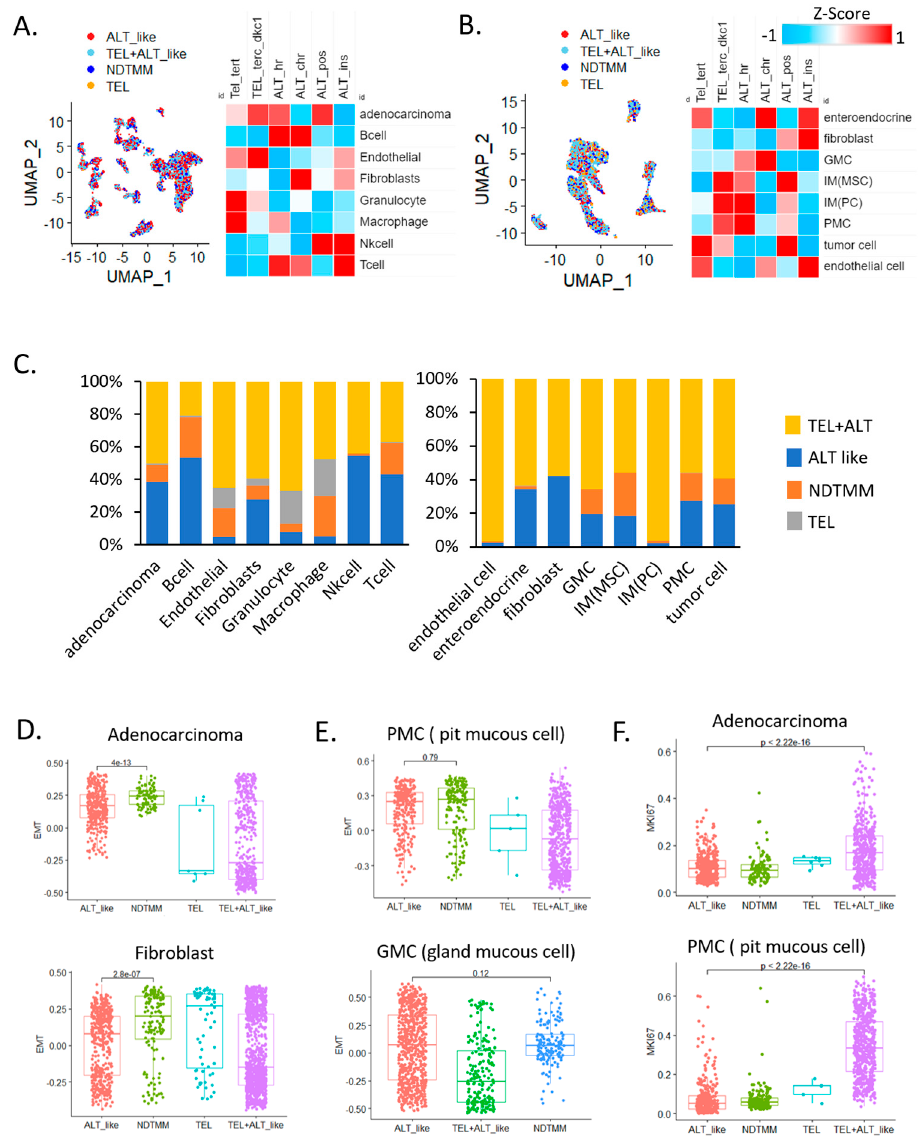
Figure 1. Single − cell analysis revealed telomere maintenance mechanisms (TMMs) in gastric cancer (GC). Uniform manifold approximation and projection (UMAP) and heat map of TMM activity of eight single − cell types in ( A ) adenocarcinoma, B cells, endothelial cells, fibroblasts, granulocytes, macrophages, natural killer (NK) cells, and T cells (12,422 cells, cohort 1) and ( B ) enteroendocrine cells, fibroblasts, gland mucous cells (GMC), mesenchymal stem cells, pit mucous cell (PMC), tumor cells, and endothelial cells (5927 cells, cohort 2). ( C ) Bar graph showing frequency of TMM types in eight single − cell types (12,422 cells, left); different cohort eight single − cell types (5927 cells, right). Boxplot of epithelial–mesenchymal transition (EMT) signature of ( D ) adenocarcinoma cells, fibroblasts, ( E ) PMC, and GMC. ( F ) Boxplot of MKI67 expression in adenocarcinoma cells (cohort 1) and PMCs.